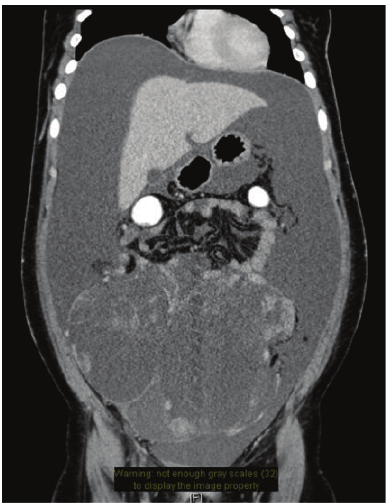
Figure 1: A chest, abdominal, and pelvic contrast-enhanced com- puted tomography (CT) scan at the portal venous phase with rectal contrast showed a huge, intraperitoneal, complex, cystic, and multi- locular lesion, extending from pelvis up to midabdomen just above umbilicus,collectivelymeasuring13.5 × 23.3 × 21.5 cm.Thesourceof lesion was more likely to be left ovary which was probably ruptured and leaked into the above-mentioned cystic lesion. In addition, large ascites was identified. No significant lymphadenopathies in abdomen and pelvis were noticed.